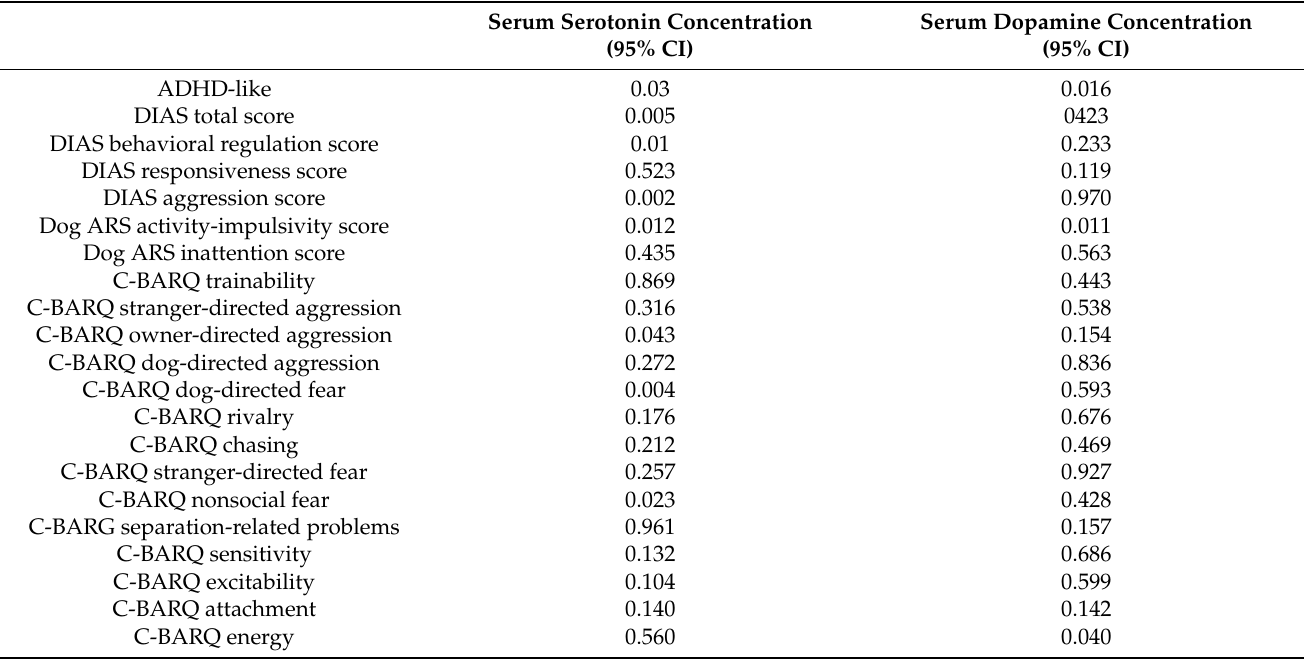
Table A1. The p -values obtained from the Kruskal–Wallis tests used to compare the mean serotonin and dopamine serum concentrations (ng/mL) in the dogs with a suspected diagnosis of being ADHD- like (vs. not ADHD-like dogs) and the dogs with scores over and under the median for the different DIAS, Dog ARS, and C-BARQ traits are shown in Table